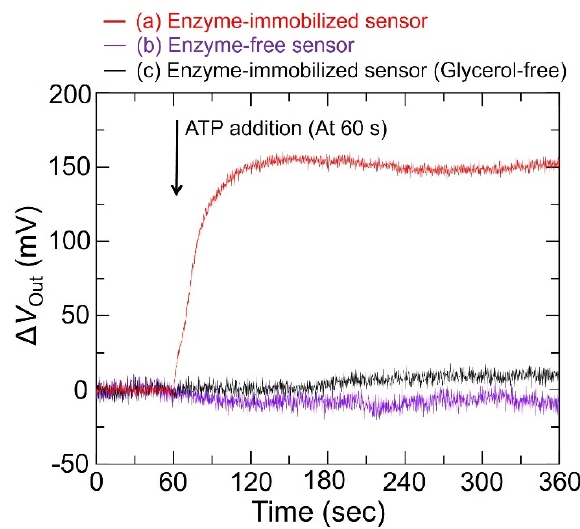
Figure 7. Characteristics investigation of output response after 1 mM − ATP was added to the sensor. (a) Typical Δ V Out − time curve to ATP measured by the enzyme − immobilized sensor, (b) time response of an enzyme − free sensor, and (c) time response of enzyme − immobilized sensor measured in no glycerol. Working buffer is 10 mM − HEPES at pH 7.4.